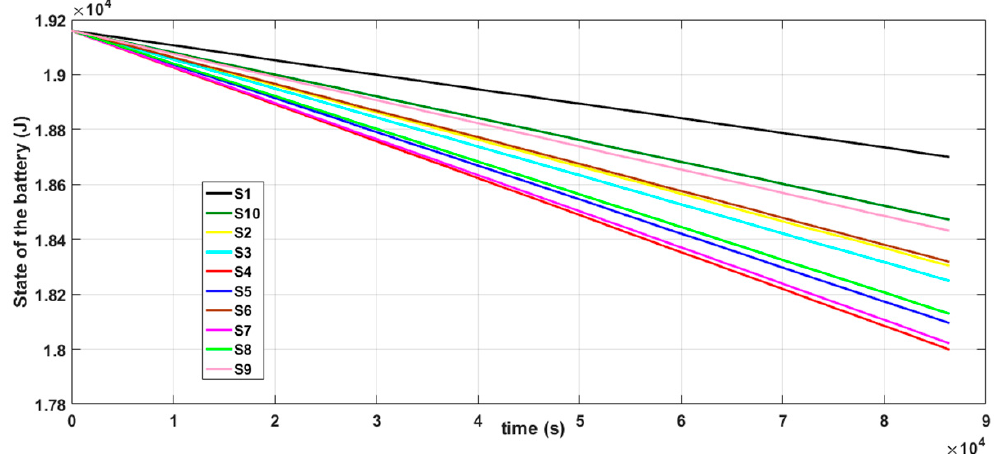
Figure 17. State of the battery of sensor nodes in distributed implementation.